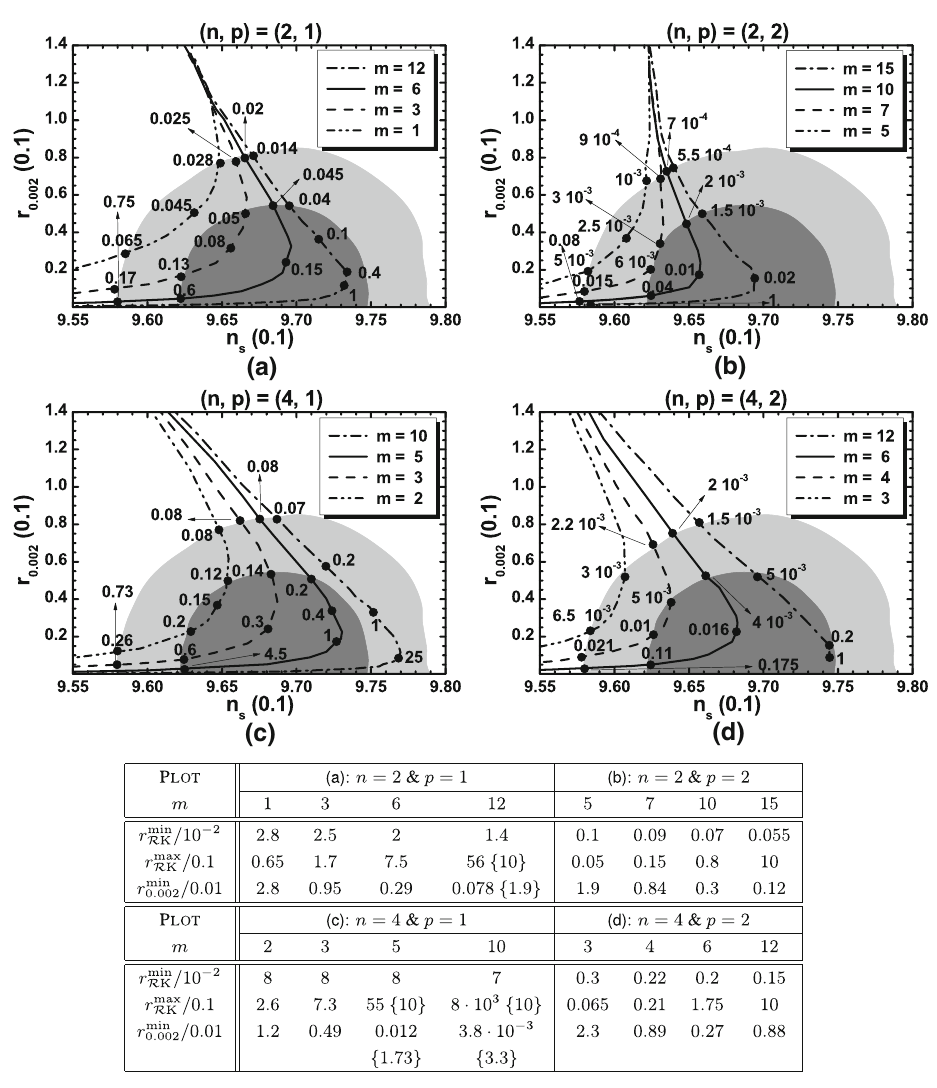
Fig. 1 Allowed curves in the n s − r 0 . 002 plane for a n = 2, p = 1 and m = 1 , 3 , 6 , and 12, b n = 2, p = 2 and m = 5 , 7 , 10 and 15, c n = 4, p = 1 and m = 2 , 3 , 5 and 10, d n = 4, p = 2 and m = 3 , 4 , 6 and 12 with the r R K values indicated on the curves. The conventions adopted for the various lines are shown in the plots. The marginalized joint 68%